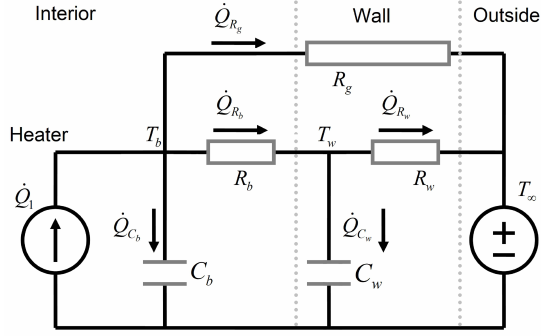
Figure 17: Simplified thermal network model with three resistors and two capacitors.